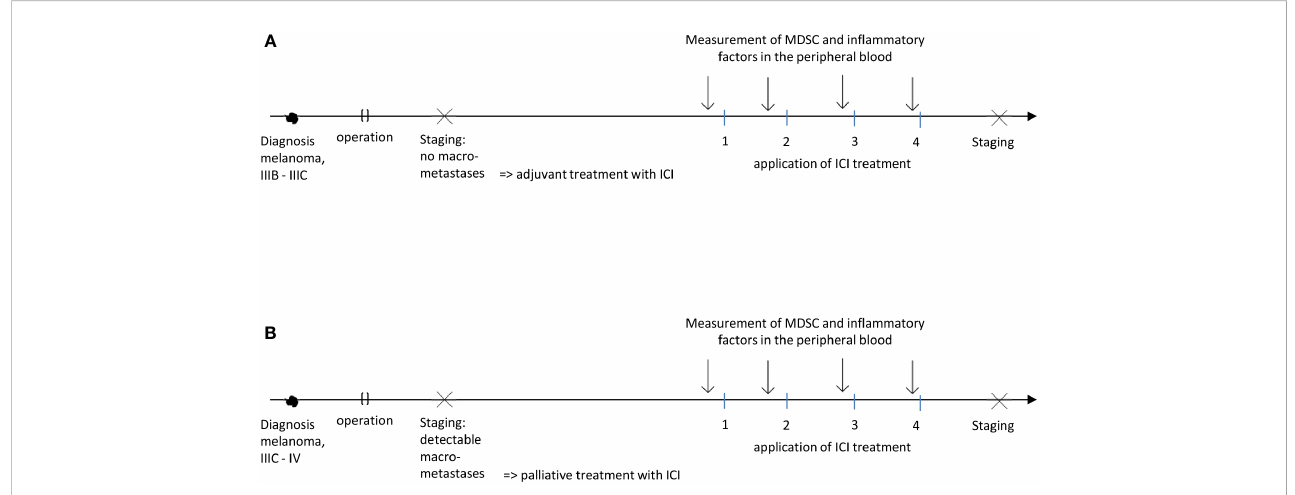
FIGURE 1 Schematic representation of adjuvant (A) or palliative (B) treatment settings (patients with no evidence of disease and those with distant metastases